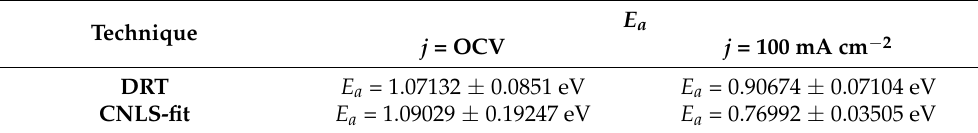
Table 4. Activation energies calculated from CNLS-fit and DRT.